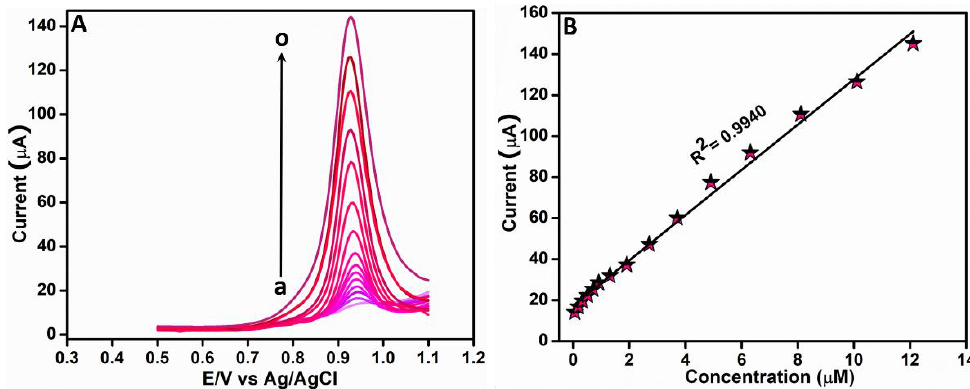
Figure 7. ( A ) DPV curves of Ag-3/ZnO/SPCE under different RhB concentrations in 0.05 M PBS (pH 7). ( B ) Linear plot of peak currents vs. RhB concentrations. Table 1. Comparison of performance of proposed modified electrode in RhB detection.